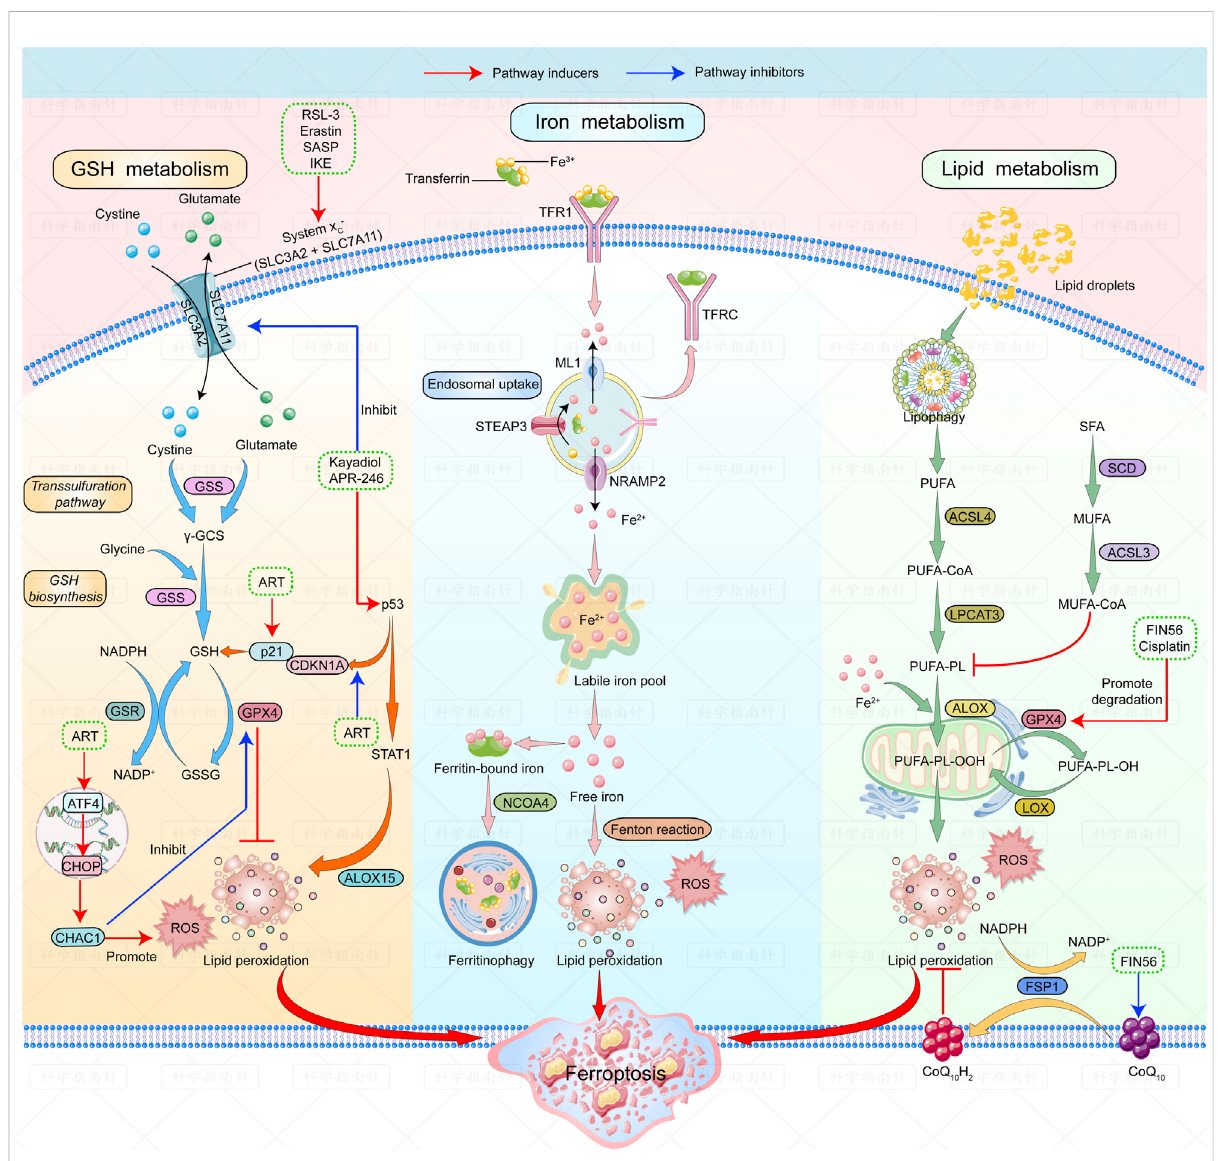
FIGURE 1 | Mechanisms of ferroptosis and ferroptosis inducers in lymphoma. The fi gureshowsthe regulatory pathways of ferroptosis can be divided into threecategories.The fi